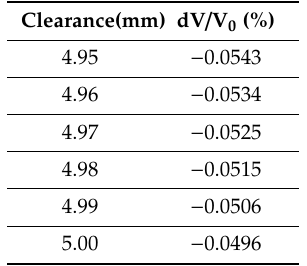
Table 1. Calibration data at near full range area. Table 2. Calibration data at near full range